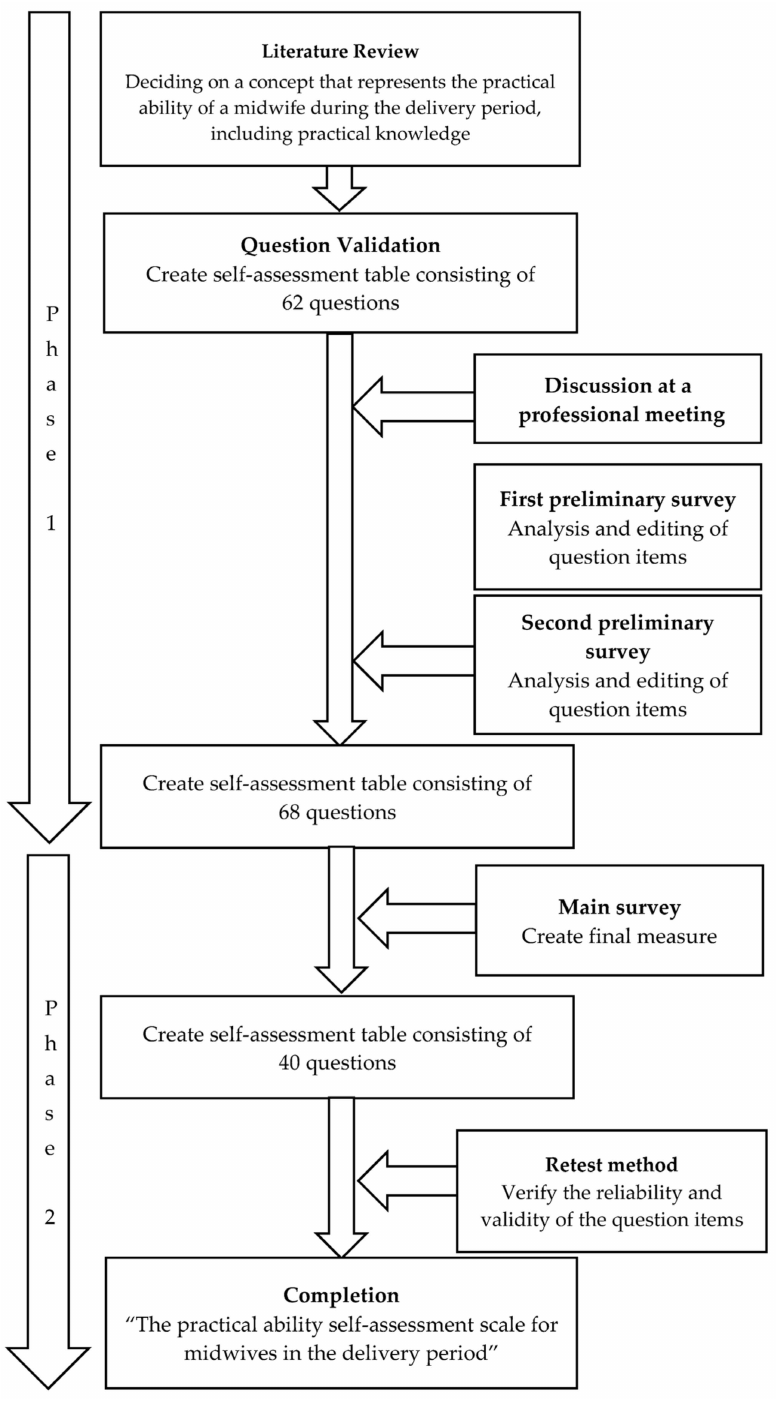
Figure 1. Flow of scale